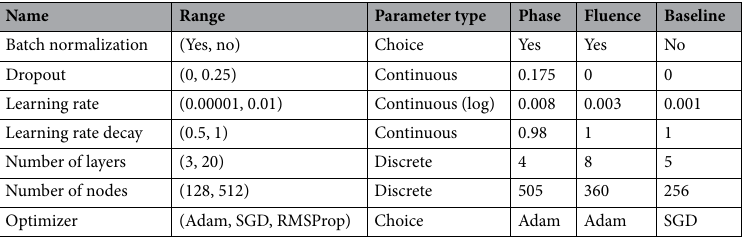
Table 1. Hyperparameter space. The hyperparmaters from the optimized phase and fluence neural networks are shown in their respective columns, along with the baseline